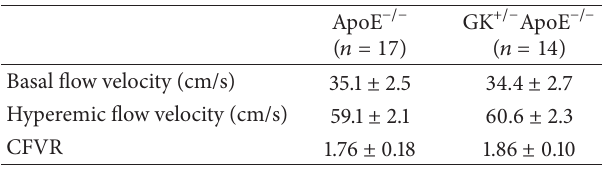
Data presented as mean ±